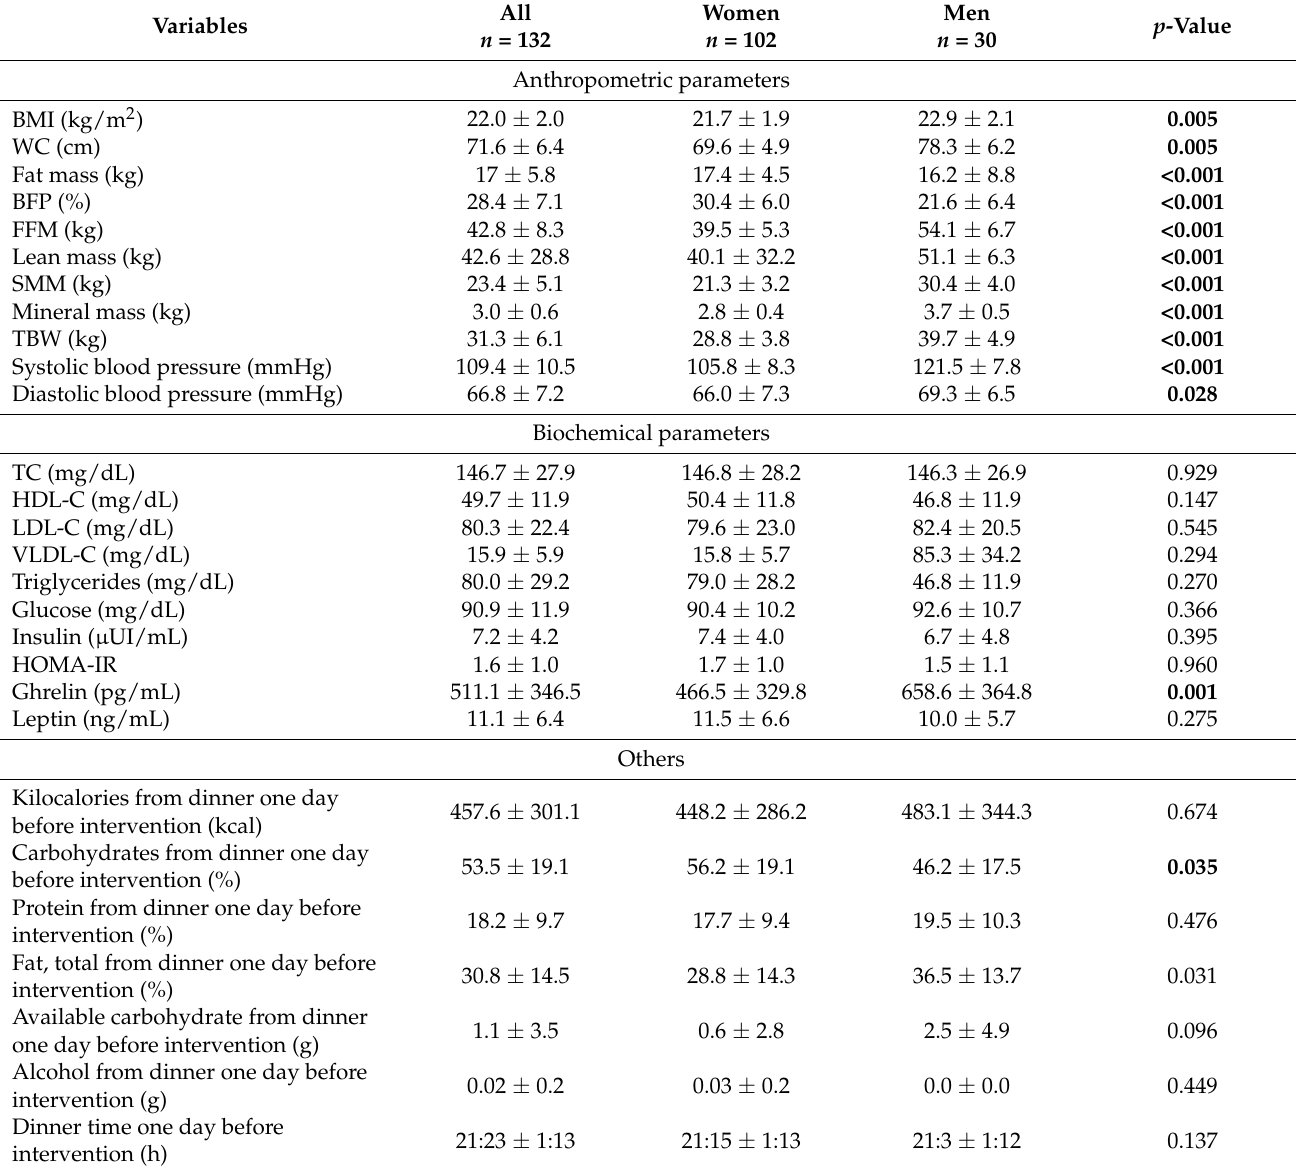
Table 1. General characteristics of the studied